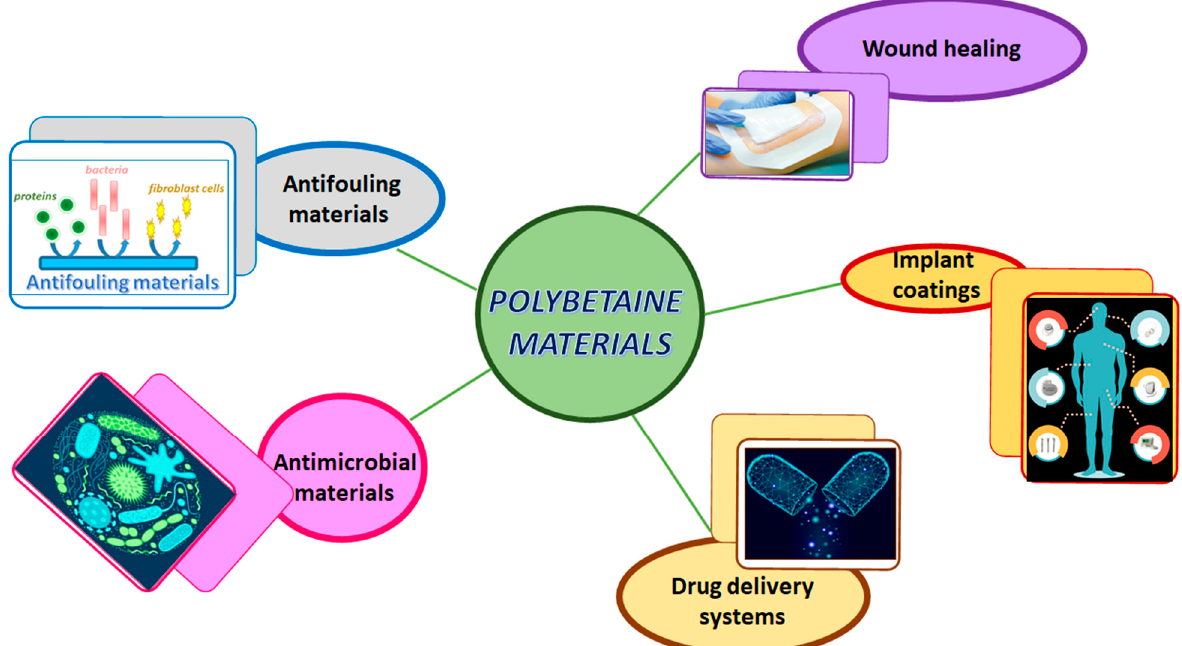
Figure 2. Biomedical applications of materials based on polybetaines.